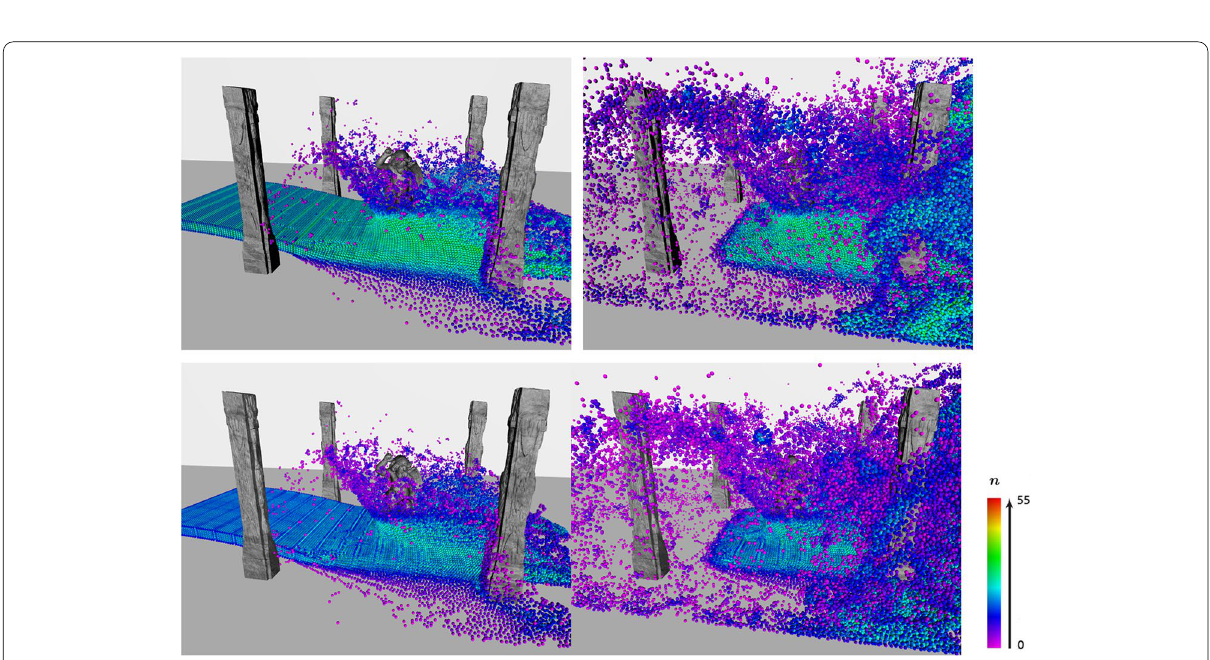
Fig. 5 Simulation of water flow impacting a sculpture in ruins using the VSLSPH (top) and DFSPH [9, 10] (bottom) methods, with 20000 particles, where the number of neighbors per particle is shown by different colors, from purple to red. In the DFSPH case, many of the particles at the splash site are purple and the ones at the fluid surface are blue, while in the VSLSPH case, particles at the splash site are blue and the ones at the fluid surface are green, showing a better distribution of the number of